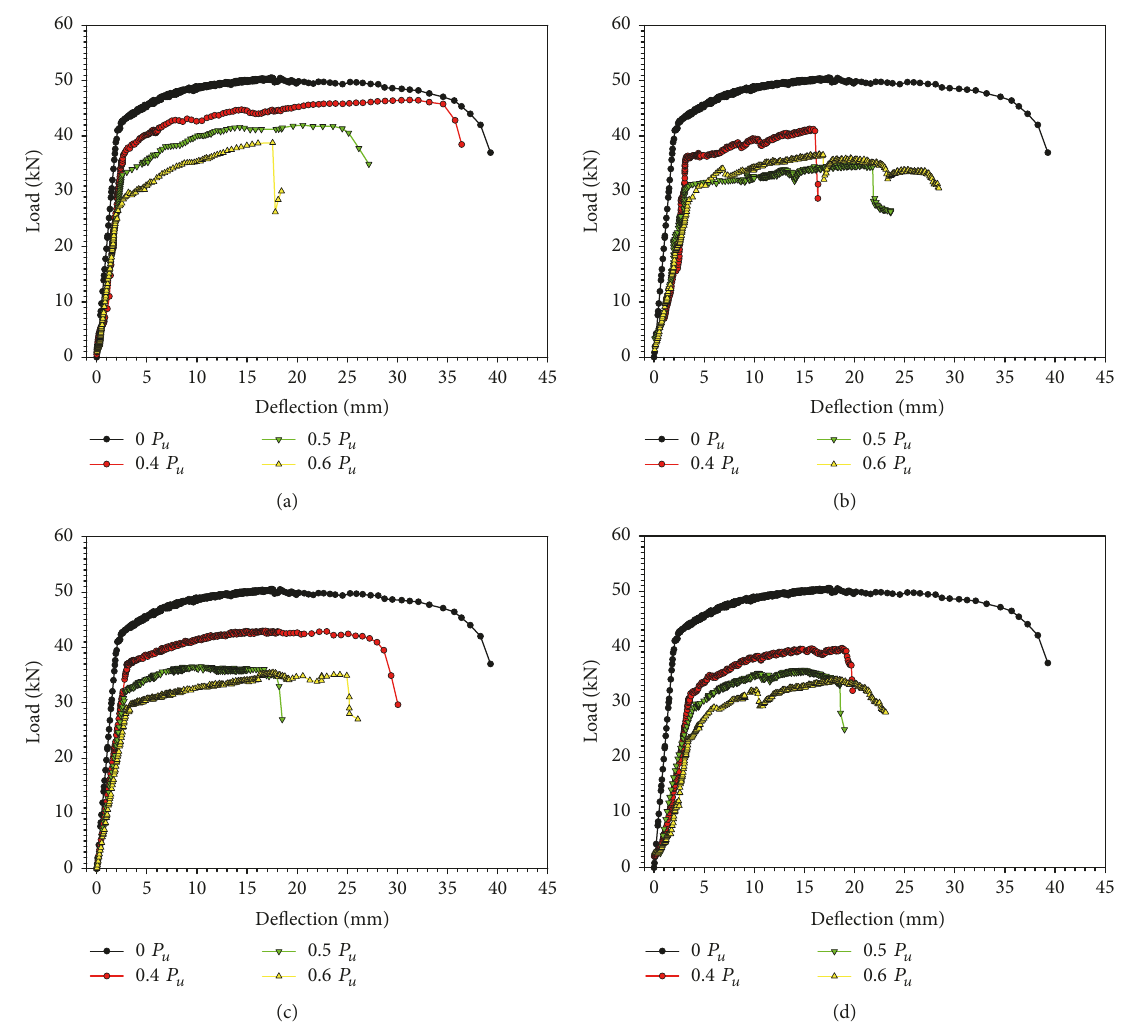
Figure 12: Load-deflection curves of RC beams: (a) 1 cycle; (b) 5 cycles; (c) 10 cycles; (d) 20 cycles.